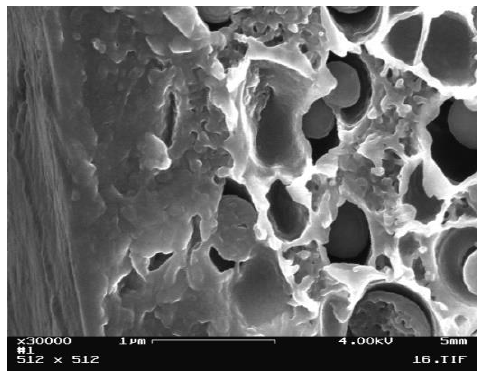
Figure 8. SEM picture of the cross-section of the membrane after hydrolysis with NaOH after 12 h. The top of the membrane is on the left side.